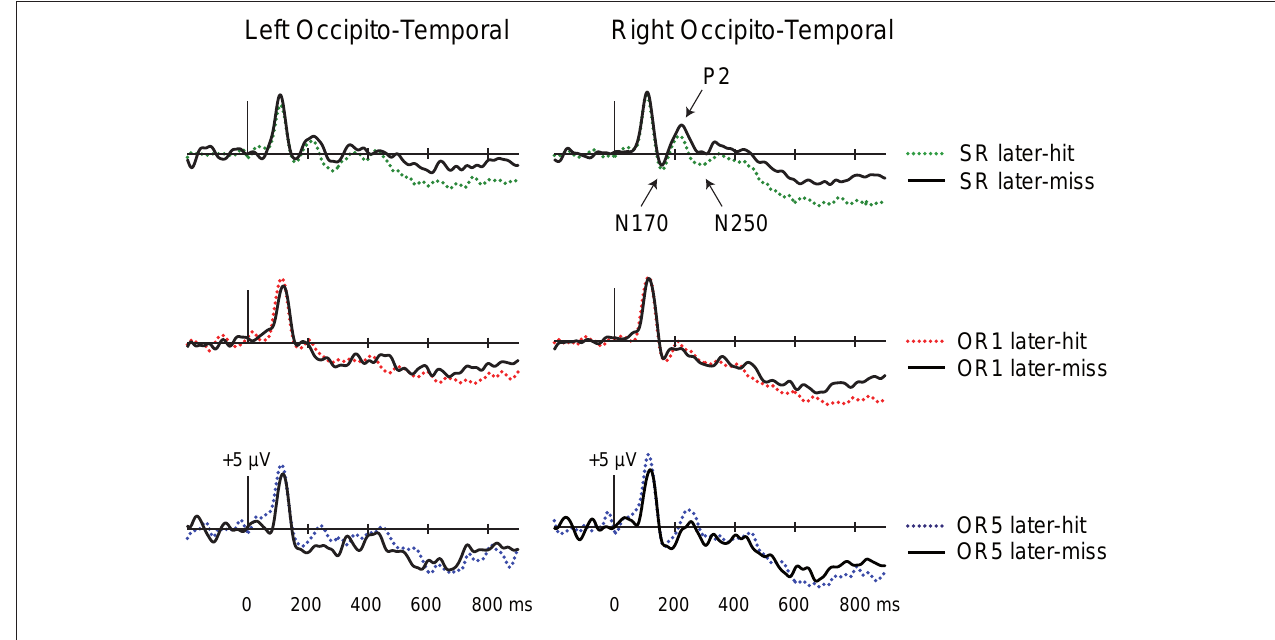
Whereas waveforms in other figures were computed using a mastoid reference, these waveforms were computed using an average reference (see